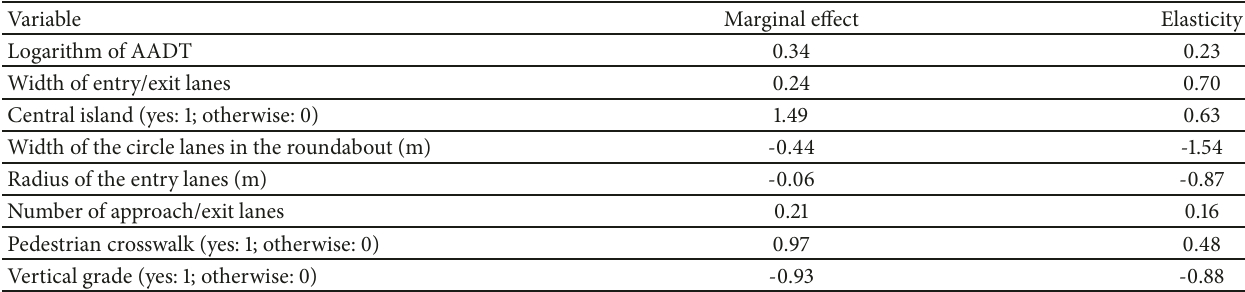
Table 6: Average marginal effects and elasticities for random parameter negative binomial